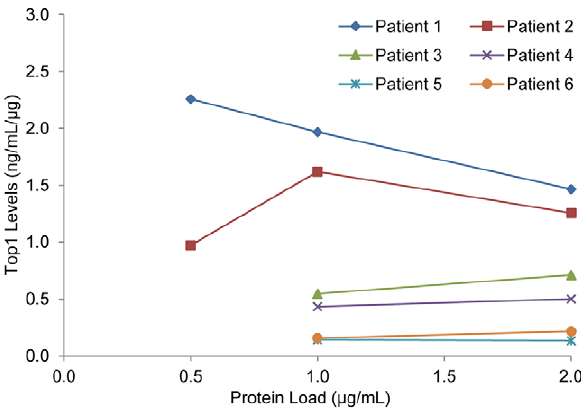
Figure 5. Baseline Top1 levels in clinical biopsy samples. Top1 levels measured in extracts prepared from pre-treatment tumor needle biopsies from 6 patients enrolled in NCI clinical trials. Top1 levels were assayed using three different protein loads for each extract. Top1 levels in biopsy extracts for the 0.5 m g/mL protein load of patients 3 to 6 were below the LLQ of the assay.